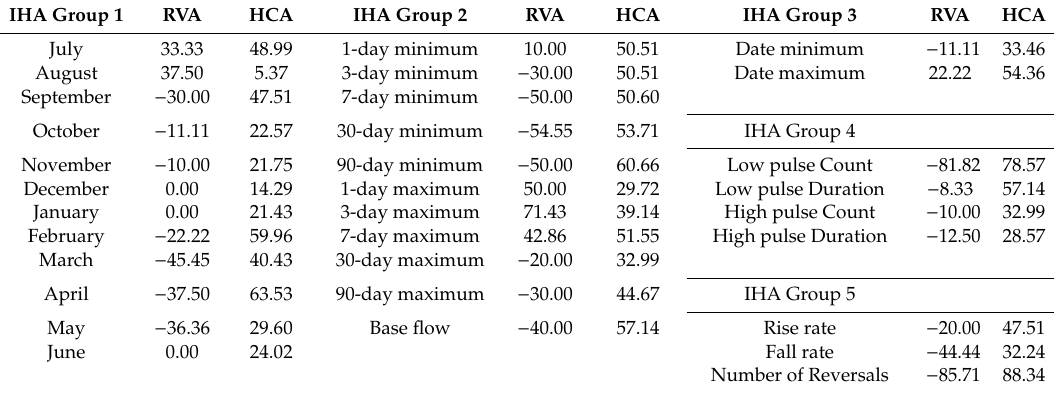
Table 6. Percentage alteration from RVA and HCA methods for the parameter of 5 IHA groups.